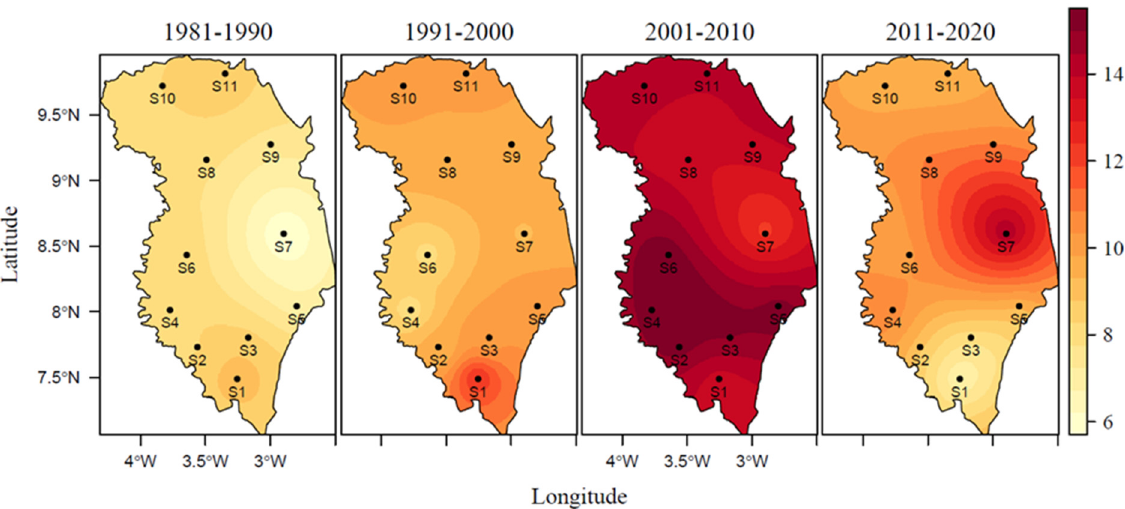
Figure 11. Spatial distribution of number of hot days (TX90p) (%) per decade in Zanzan region. Stations (S1 = Koun Fao, S2 = Kouassi-datékro, S3 = Tanda, S4 = Sandegué, S5 = Bondoukou, S6 = Nassian, S7 = Sapli, S8 = PN Comoé S1, S9 = Bouna, S10 = Téhini, S11 = Doropo).